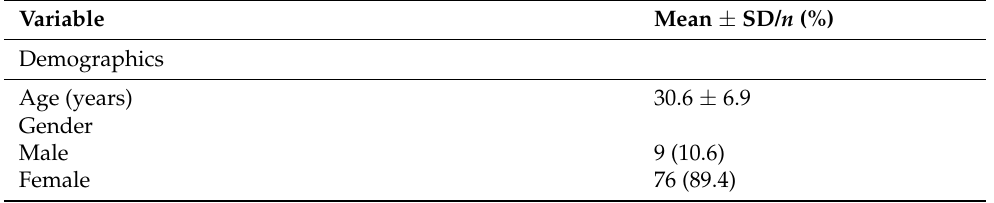
Table 1. Basic characteristics of critical care nurses caring for critical patients with COVID-19 ( n = 85).